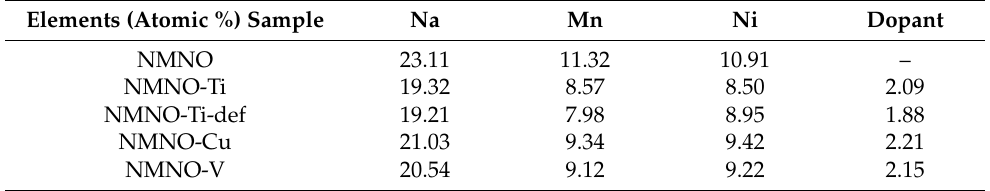
Figure 4. SEM micrographs of undoped and doped samples. Table 1. Elemental composition (at %) of all the samples as determined by EDS